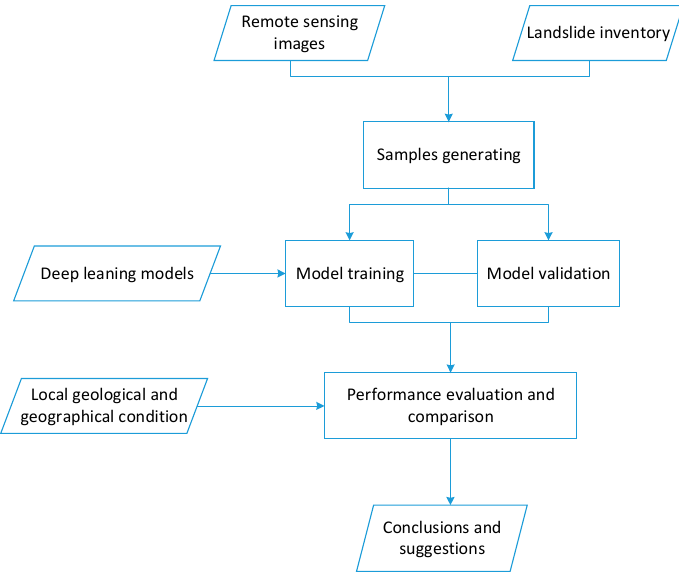
Figure 2. The flowchart of this study.